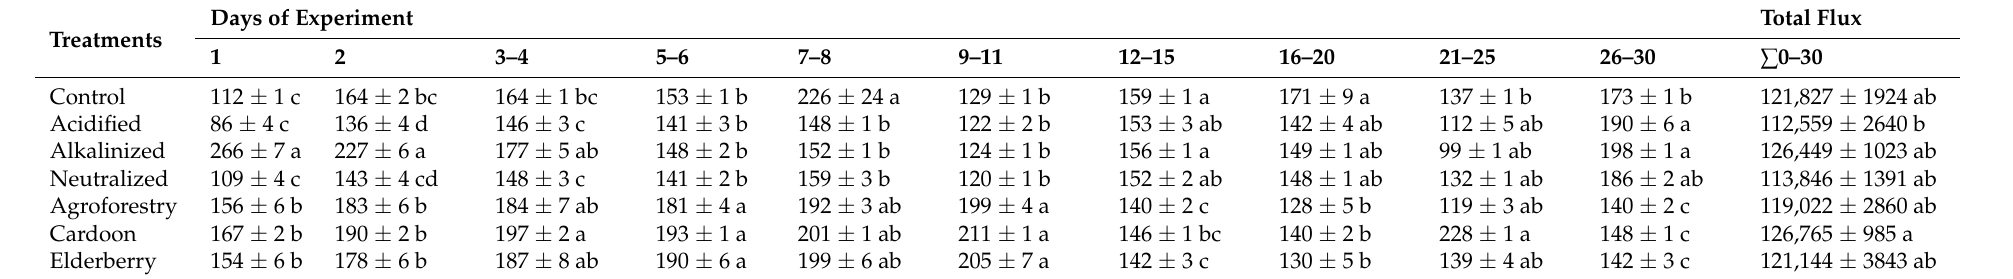
Table 7. Mean values of daily (mg m − 2 h − 1 ) and total (mg m − 2 ) methane fluxes observed in the treatments (mean ± standard deviation) ( n =